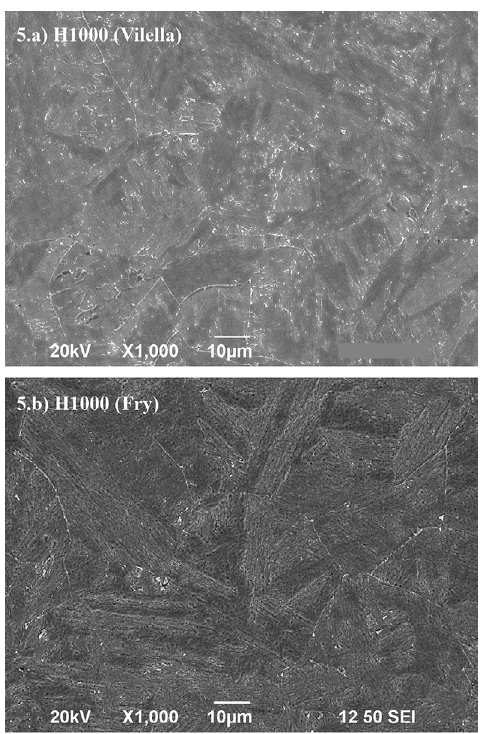
Figure 3. SEM images of solution heat treated condition, etched with: (a) Vilella and (b) Fry.